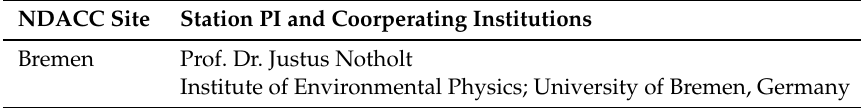
Table A2. NDACC site used in this publication, along with the station’s principle investigator (PI) and cooperating